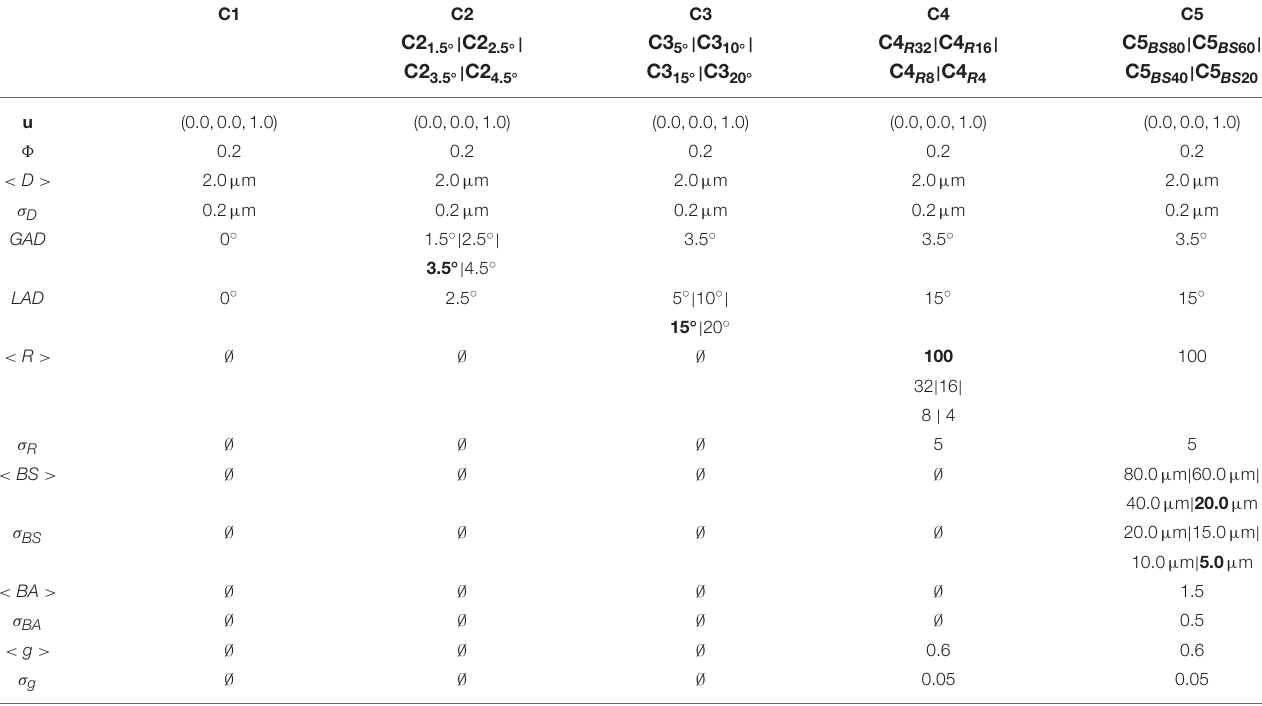
TABLE 2 | Values of the control parameters of the phantom generation algorithm for each studied configuration (C1 to